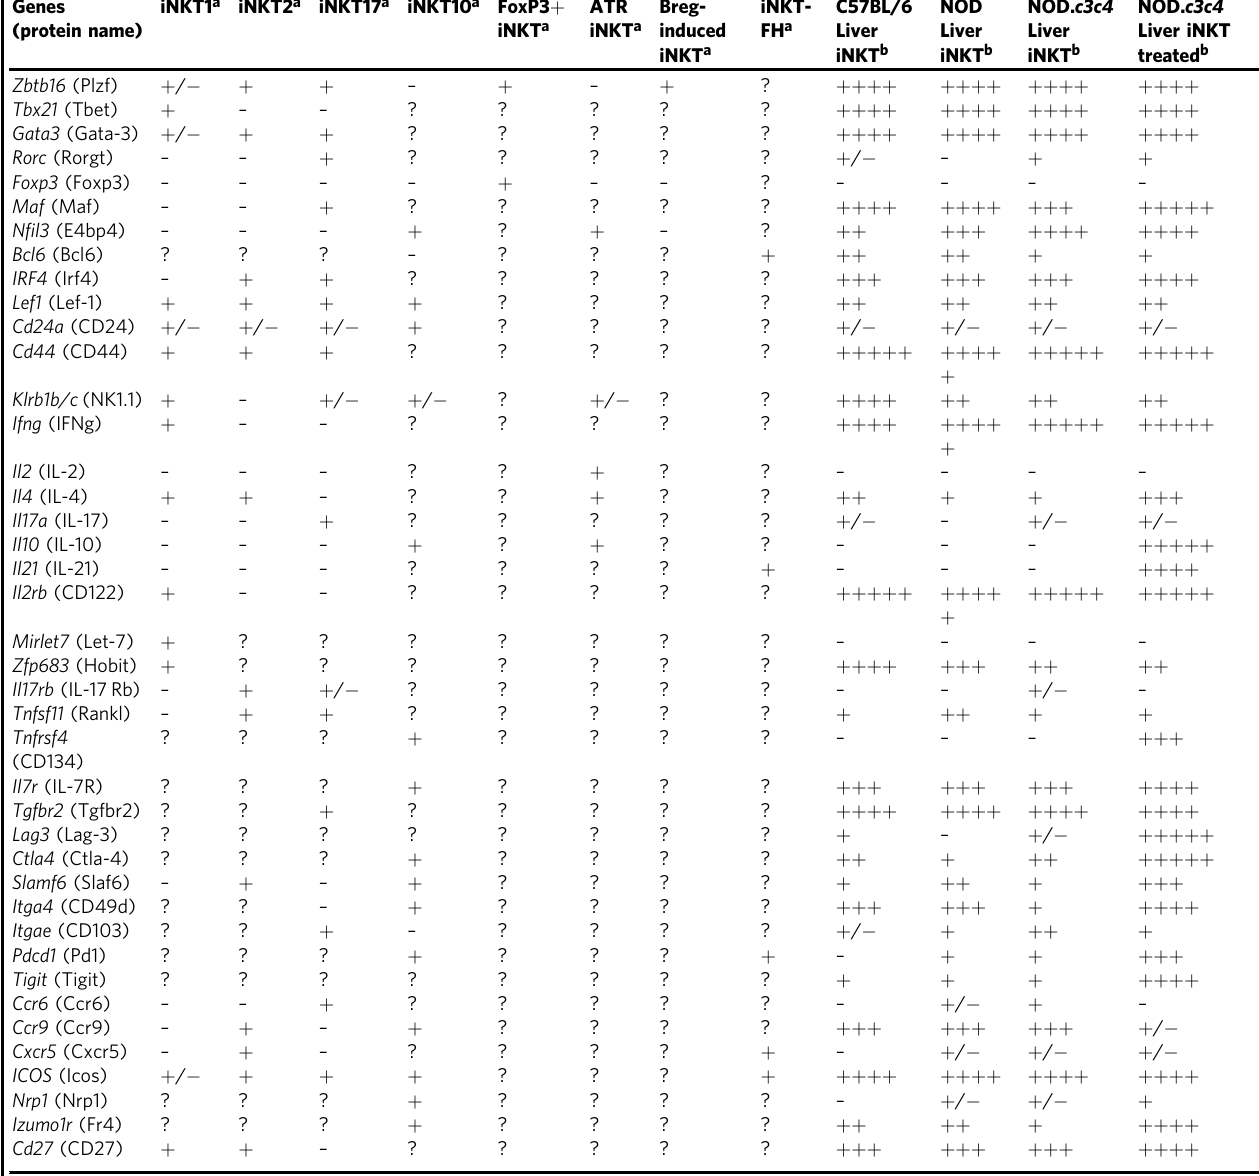
Table 1 Gene expression differences for iNKT cell markers and on known iNKT cell subsets vs. LiNKTs and LiNKTR1